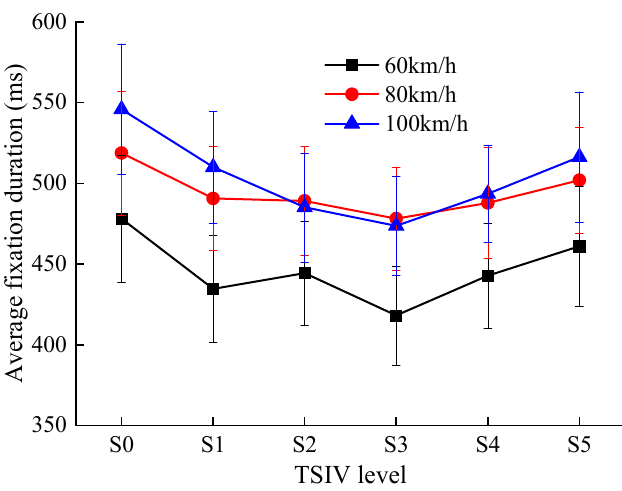
Figure 8. The comparison of average fixation duration for each TSIV at the three